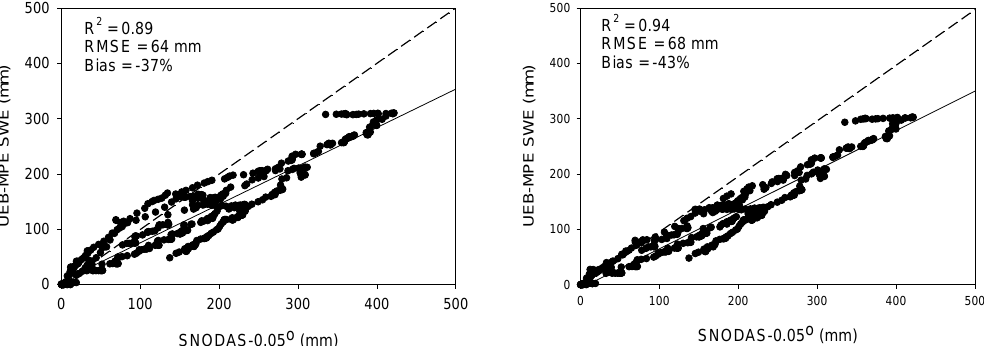
Fig. 11. Scatterplots of average daily SWE (at the 39 SNOTEL sites) from the SNODAS and the (A) SWE from simulated with UEB and MPE precipitation and the original GFS air temperature for January 2006–April 2008, and (B) SWE simulated with UEB and MPE precipitation and the original GFS air temperature increased by 2 ◦